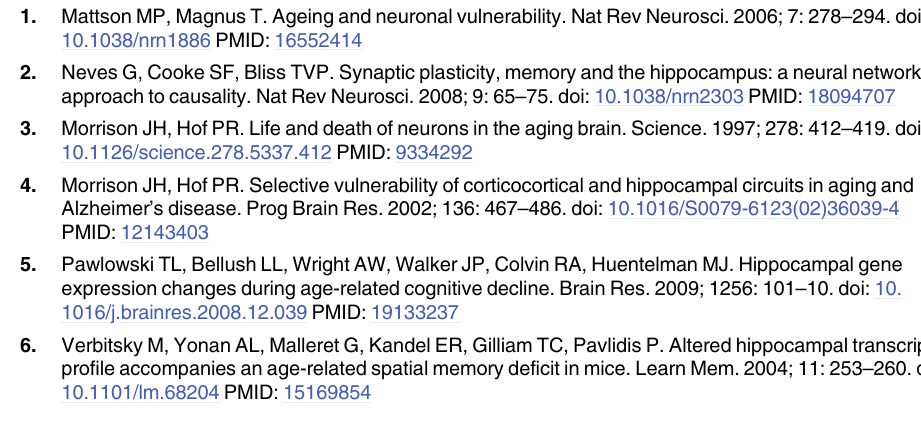
S1 Table. Total differentially expressed genes in normal aging in the hippocampal CA1 region (AL, 15 vs. 5 months). S2 Table. Total differentially expressed genes as a function of diet in the aged hippocampal CA1 region (15 months, CR vs. AL). S3 Table. Transcriptional changes implicated in IPA predictions of CR-opposed cellular functions during normal aging. (p < 0.01, q < 0.05). S4 Table. Signature of 882 age-dependent expression changes suppressed by CR. S5 Table. Age-dependent transcriptional changes exacerbated by CR. (p < 0.01, q < 0.05). S6 Table. Total differentially expressed genes as a function of diet in the young hippocam- pal CA1 region (5 months, CR vs.